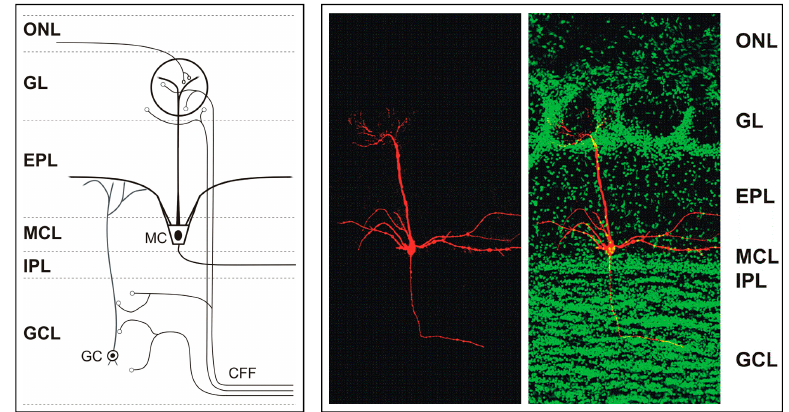
Figure 1. Left: Simplified diagram of the main olfactory bulb to illustrate its different layers, mitral cells (MCs), granule cells (GCs), and centrifugal fibers (CFF). The olfactory nerve layer (ONL) contains the axons of olfactory receptor neurons, which synapse in the spheroidal glomeruli on MCs, and other neurons. For clarity, glomerular layer (GL) cell types have been omitted from the diagram. The dendrites of the mitral cells pass from the GL through the external plexiform layer (EPL) into the mitral cell layer (MCL) which contains the cell bodies of mitral cells and many granule cells. The internal plexiform layer (IPL) contains the axons of the principal output cells (mitral cells and tufted cells) as they course to cortical areas. The granule cell layer (GCL) contains most of the granule cells as well as other inhibitory cells. CFF bring modulatory feedback signals from cortical areas, to synapse in the glomerular layer and granule cell layer. EPL, IPL—external, internal plexiform layer. Right: Adult mouse main olfactory bulb section with a single mitral cell intracellularly filled with biocytin (red) and nuclei stained with counterstain Sytox Green (green). The mitral cell soma is located in the MCL. One apical dendrite reaches into one glomerulus and several lateral dendrites span the main olfactory bulb. Modified from [3].